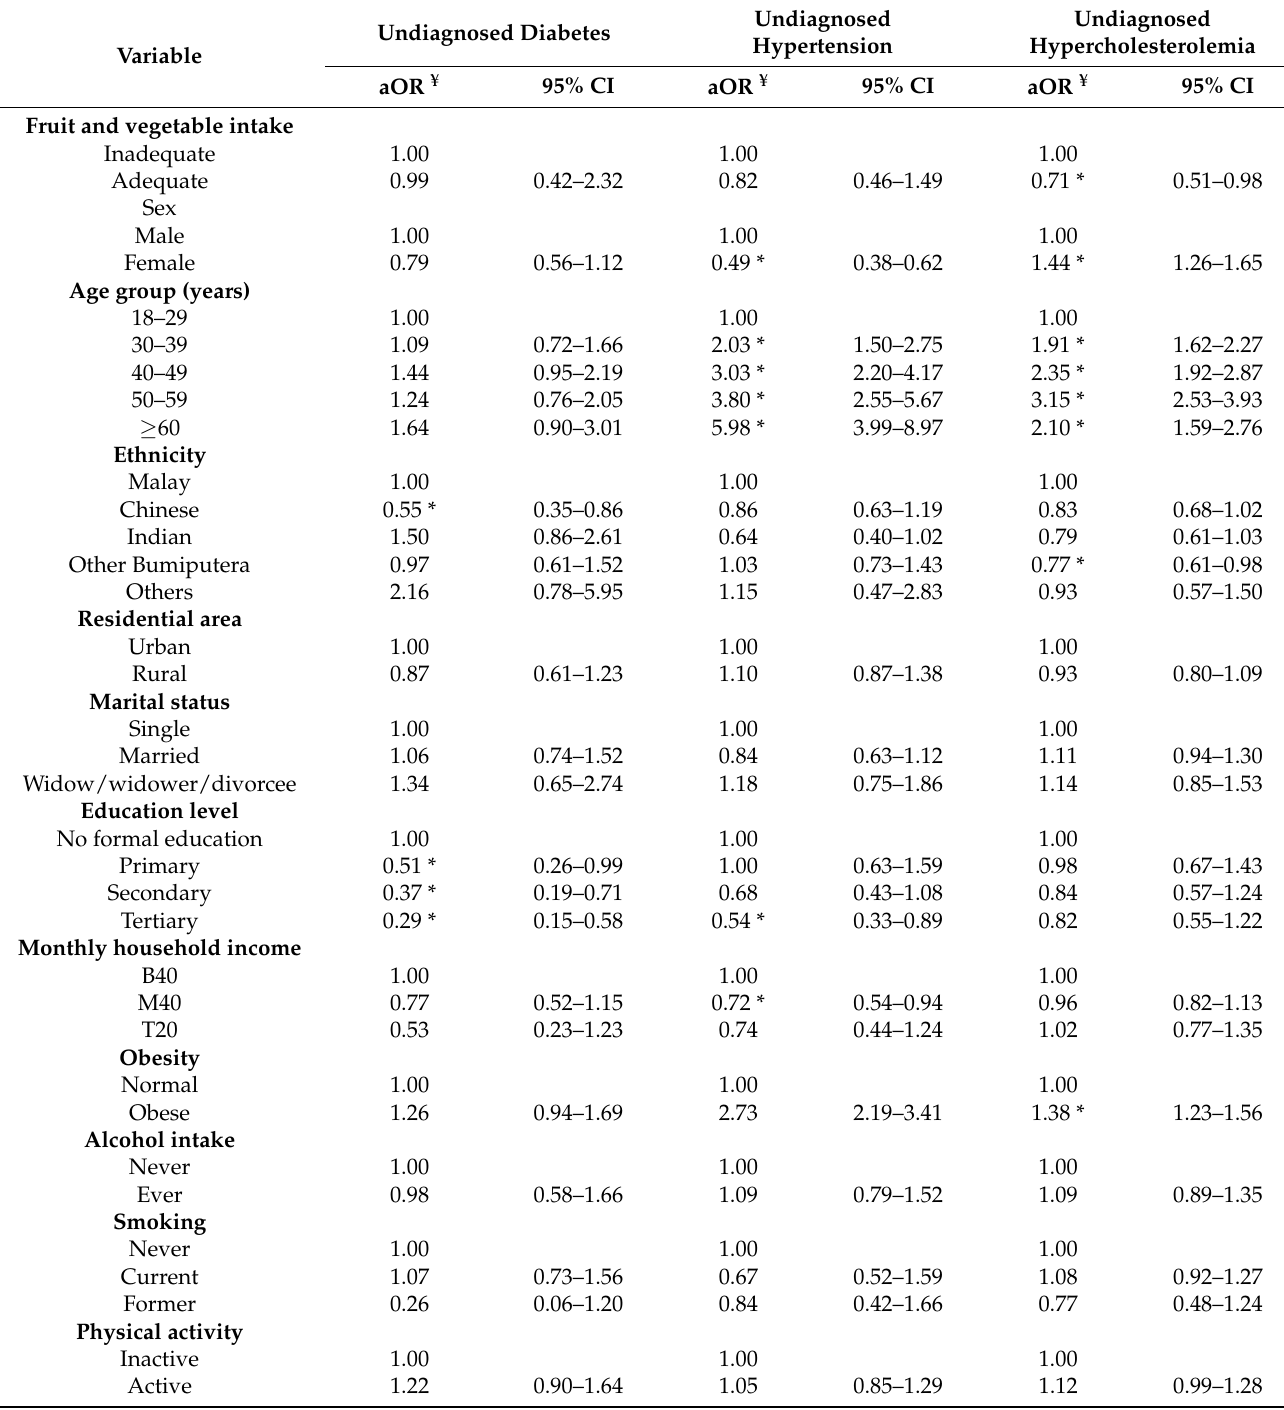
Table 3. Associations between adequate fruit and vegetable intake and undiagnosed diabetes, undiagnosed hypertension, and undiagnosed hypercholesterolemia in Malaysian adults aged 18 years and